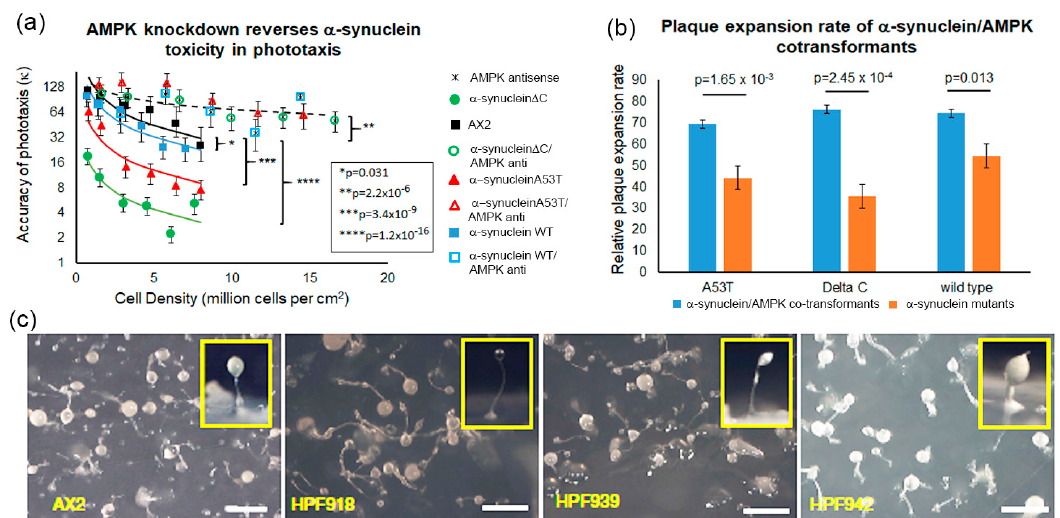
Figure 7. Ability of AMPK knockdown to rescue phenotypic defects caused by expression of wild type and mutant forms of α -synuclein. ( a ) Quantitative phototaxis. The parental strain AX2, α -synuclein WT HPF885 (38) and α -synuclein WT/antisense AMPK HPF918 (211, 28), α -synuclein A53T HPF902 (27) and α -synuclein A53T/antisense AMPK HPF940 (272, 153), and α -synuclein Δ C HPF905 (12) and α -synuclein Δ C/antisense AMPK HPF942 (215, 142) were statistically analysed and the accuracy of phototaxis ( κ ) was plotted against their cell densities. When compared to AX2, all the strains showed a high accuracy of phototaxis which suggests that the down regulation of AMPK rescues the phototaxis defect observed in α -synuclein-expressing strains. The multiple log–log regressions were done using the “Backwards” method to remove insignificant variables at a significance cut-off of 0.01. The resulting p values (indicated by asterisks and shown in the box inset) indicate the significance of the indicated differences (indicated by curly brackets) between the fitted regressions in the final model. Lines show the final fitted regression model and the error bars represent 90% confidence intervals for the individual data points. ( b ) Knocking down expression of AMPK partially rescues the impaired growth on bacterial lawns caused by WT or mutant α -synuclein. The plaque expansion rate of the strains expressing any of the three α -synuclein proteins were greatly reduced compared to the parental strain AX2. The cotransformants expressing WT or mutant α -synuclein and with reduced AMPK displayed partially rescued growth rates better than the single α -synuclein strains but still not as high as the parental strain AX2. All strains were grown on E. coli B2 lawns on SM agar and the plaque expansion was measured over a one hundred hour period. Each cell line was measured in triplicate in three independent experiments. The di ff erences were significant at indicated p values ( t -test) and error bars represent standard errors of the mean. ( c ) Knocking down AMPK does not rescue the impaired morphology caused by α -synuclein with a deletion of the C-terminus. The parental strain AX2, the WT- α -synuclein / antisense-AMPK strain HPF918, the A53T- α -synuclein / antisense-AMPK strain HPF939 and the α -synuclein ∆ C / antisense-AMPK strain HPF942 are shown. The WT- α -synuclein / antisense-AMPK and A53T- α -synuclein / antisense-AMPK resemble the parental strain AX2, while the α -synuclein ∆ C / antisense AMPK results in fruiting bodies with shorter, thicker stalks when compared to AX2. This phenotype is similar to the α -synuclein ∆ C strain suggesting that antisense inhibition of AMPK does not rescue the defective morphogenesis phenotype. The scale bar shows 1